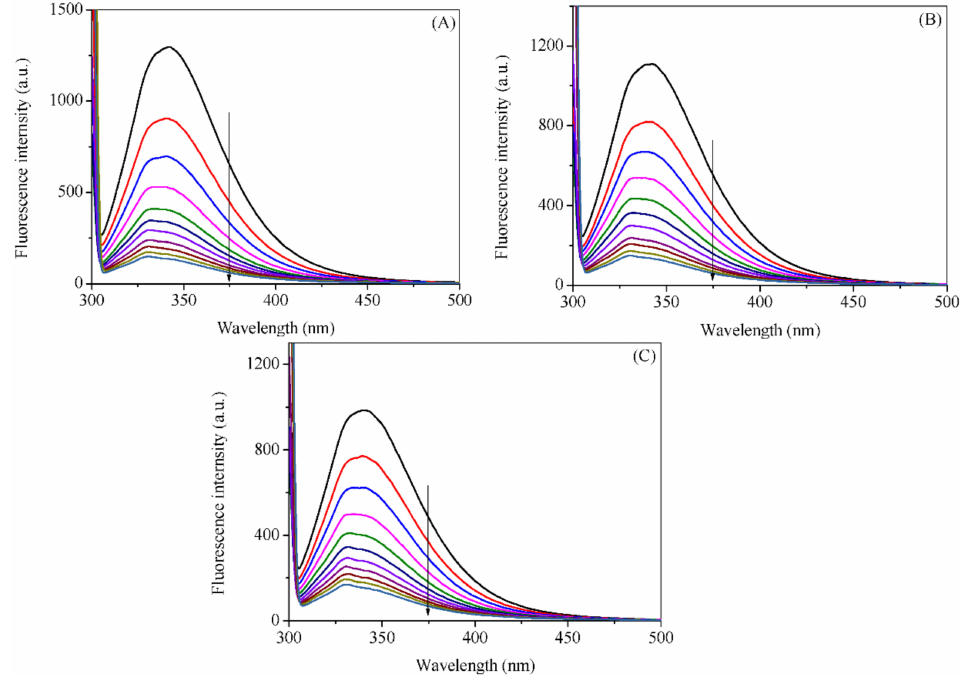
Figure 2. Fluorescence emission spectra of HSA in the absence and presence of cuminaldehyde at 25 ◦ C ( A ), 35 ◦ C ( B ), and 45 ◦ C ( C ). λ ex = 295 nm. The concentration of HSA was 3.0 µ M, while concentration of cuminaldehyde varied from 0 to 400 µ M with a regular increment of 40 µ